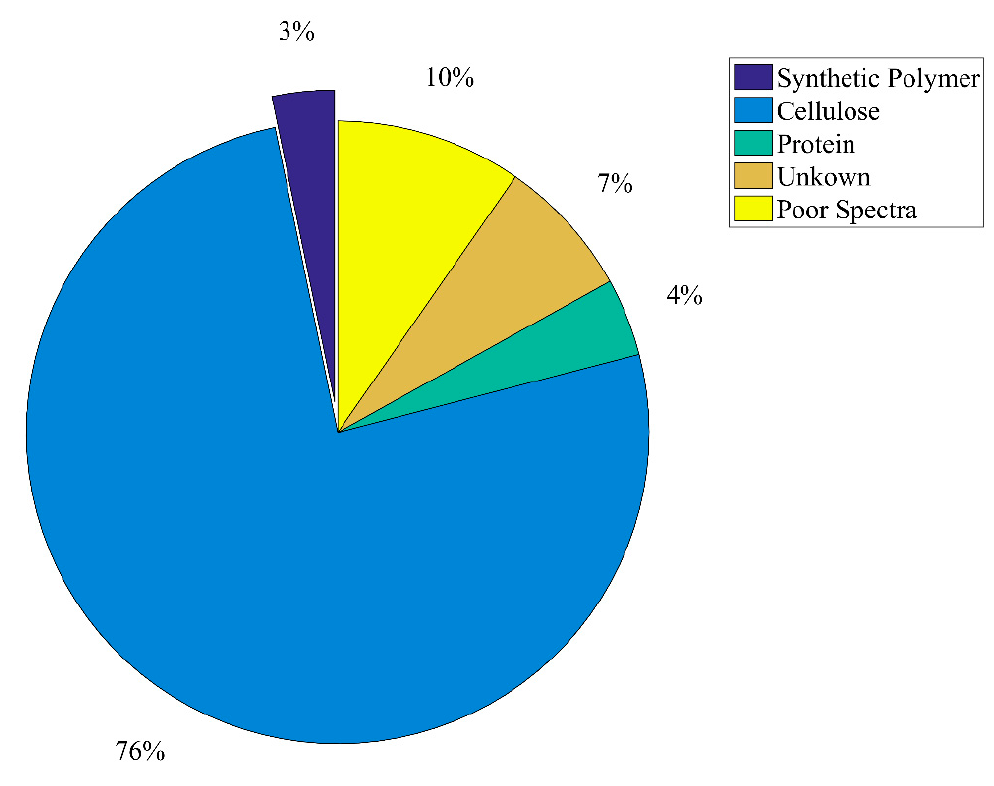
Figure 3. Categorisation of the MP-like particles (>100 µ m) selected for characterization by µ -FTIR. Among the confirmed MP particles, two transparent fibers were identified as PP and PET from site 7 and site 16, respectively. The majority of the observed fibers, which showed a characteristic white colour, as well as all the bright coloured fibers, were identified as cellulosic by µ -FTIR analysis. The two remaining confirmed MP particles were transparent PS and PP fragments from sites 8 and 15, respectively. Fragments were observed in the ma- jority of the water samples (12 sites), and the number of MP-like fragments ranged from 0 to 7 per sample. Most of the fragments categorised as MP-like were either white/transparent or black, while the occurrence of fragments with strong colours in the water samples was very low. MP-like films were the least frequently occurring type of particles observed in the water samples and none of them were verified as MP by spectroscopy analysis. Figure 4 shows the MP particles/fibers and the respective µ -FTIR spectrum observed in the Danish drinking